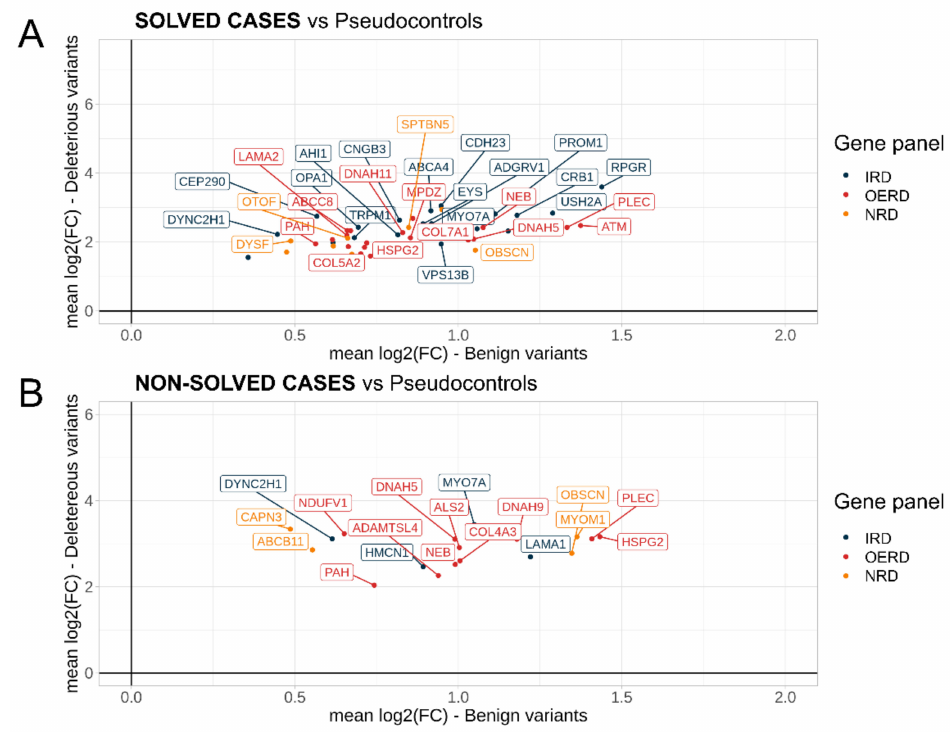
Figure 3. Genes with a higher accumulated pathogenicity in solved and non-solved IRD cases compared to pseudocontrols. Mean fold changes (FCs) in log2 scale for deleterious (Y-axis) and benign variants (X-axis) are shown for each gene. For IRD solved cases, significative genes with at least eight deleterious variants are shown in the plot ( A ). For IRD non-solved cases, all significative genes are shown ( B ). Table 3. Genes with more frequent deleterious variants in IRD non-solved cases than in pseudo- controls. The genes are sorted by the gene panel where they are present (IRD, OERD, and NRD) and by number of deleterious variants. The gene panel column refers to the type of diseases that the gene has been associated with, inherited retinal dystrophies (IRD), other eye-related diseases (OERD), and other non-eye-related diseases (NRD). Number of deleterious and benign variants in IRD non-solved cases is shown. FDR stands for false discovery rate of the Wilcoxon rank sum test performed. Inheritance mode associated with each gene is annotated in the “Inheritance” column as recessive, dominant, or R/D (either recessive or